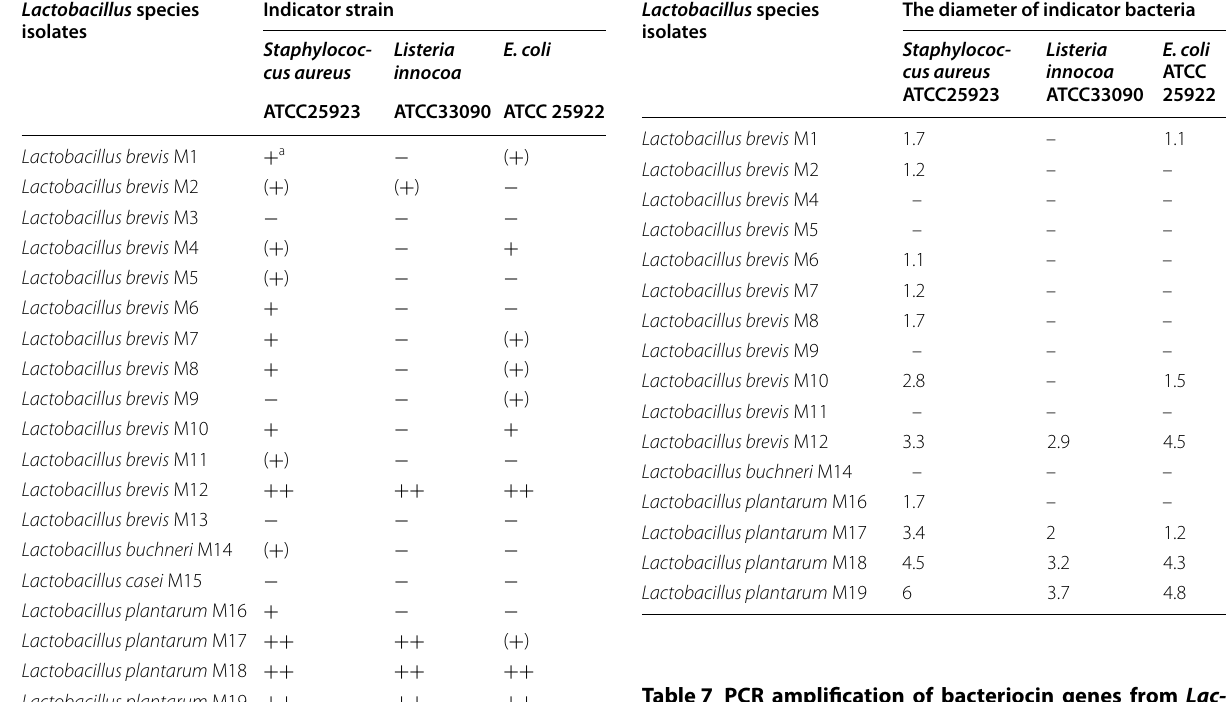
Table 7 PCR amplification of bacteriocin genes from